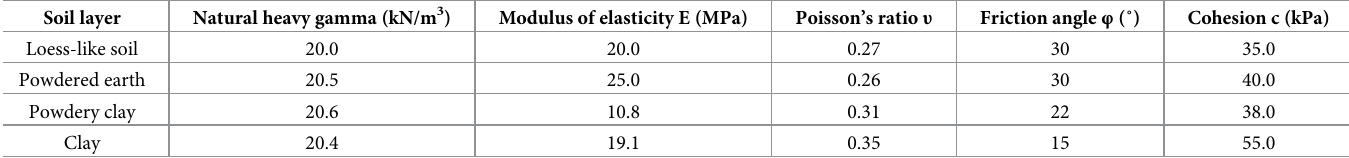
Table 1. Soil parameters of the soil